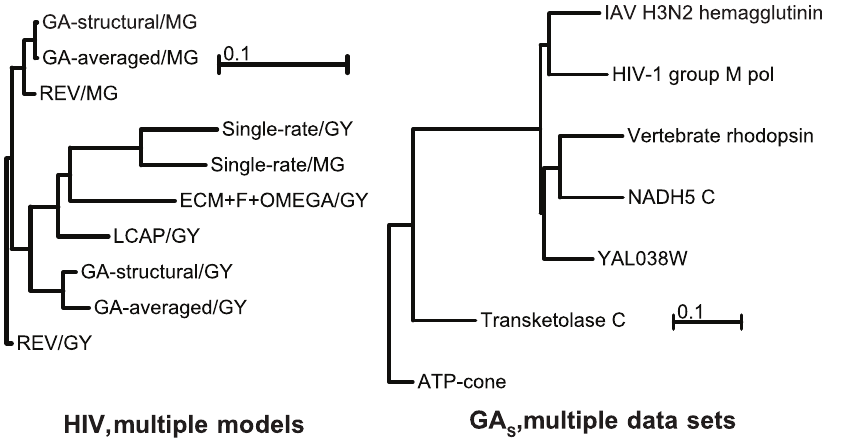
Figure 3. Neighbor-joining [57] trees built from matrices of pairwise substitution spectrum distances (Eq. 2) computed between different models fitted to the HIV-1 group M pol alignment, and between GA s models inferred from different alignments.